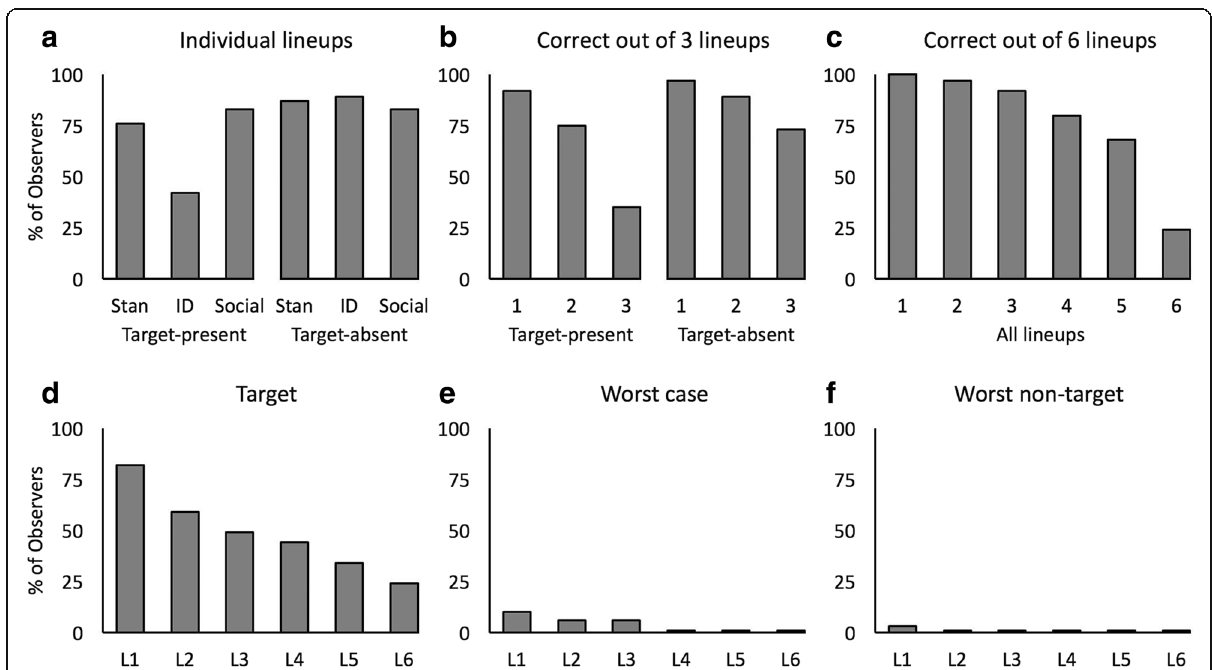
Fig. 5 Illustration of observers ’ responses in Experiment 3, showing hits for individual target-present and correct rejections for individual target- absent lineups ( a ), the number of hits and correct rejections out of three lineups ( b ), and the combined number of hits and correct rejections out of six lineups ( c ). In addition, observers ’ combined hits and correct rejections were analyzed by adhering to the order in which the six lineups were seen, for the target ( d ), the worst case analysis ( e ), and for the worst non-target ( f )